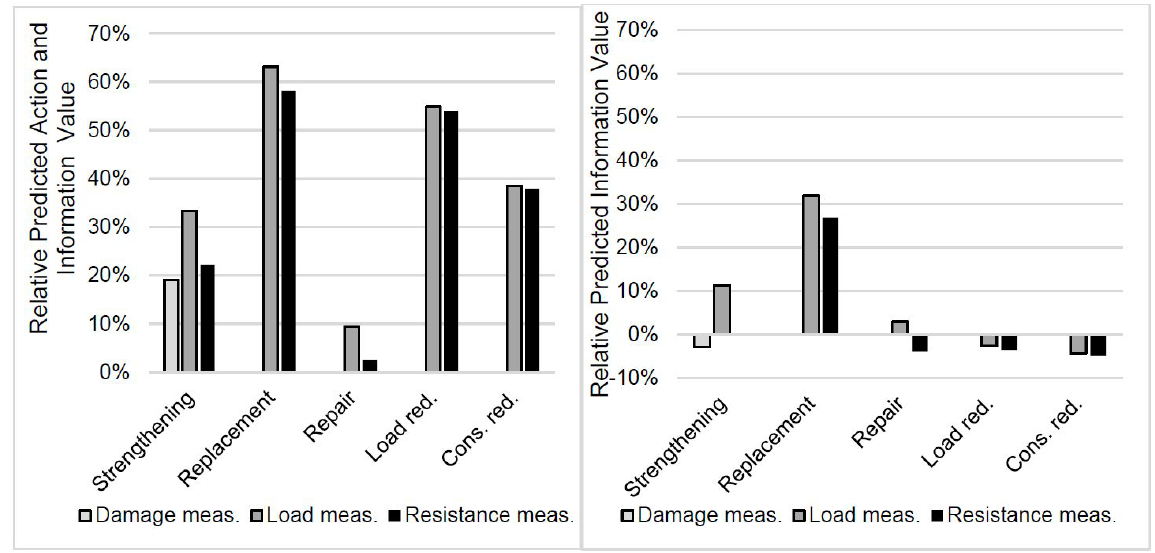
Figure 3. Relative predicted action and information values for damage, load and resistance